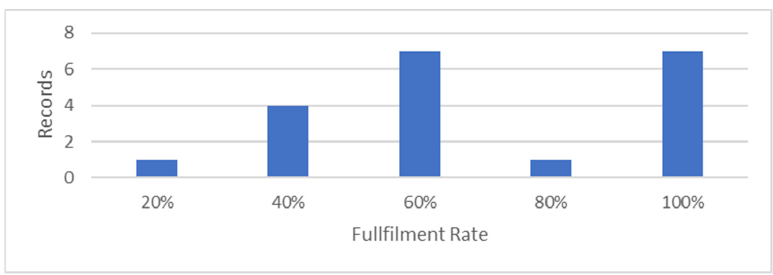
Figure 9. Distribution of fulfillment rate.